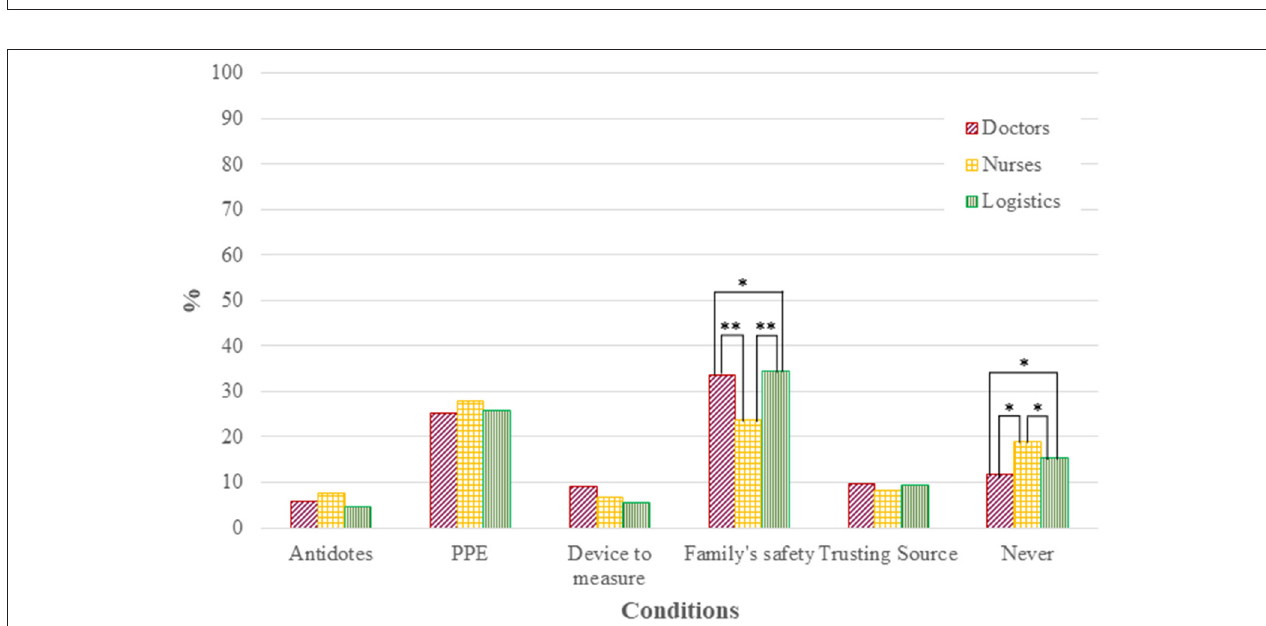
FIGURE 1 | The most important event that may prevent the respondent from coming to work. * p < 0.05, ** p < 0.01. NPP indicates nuclear power plant. Chart showing response to Question 1.